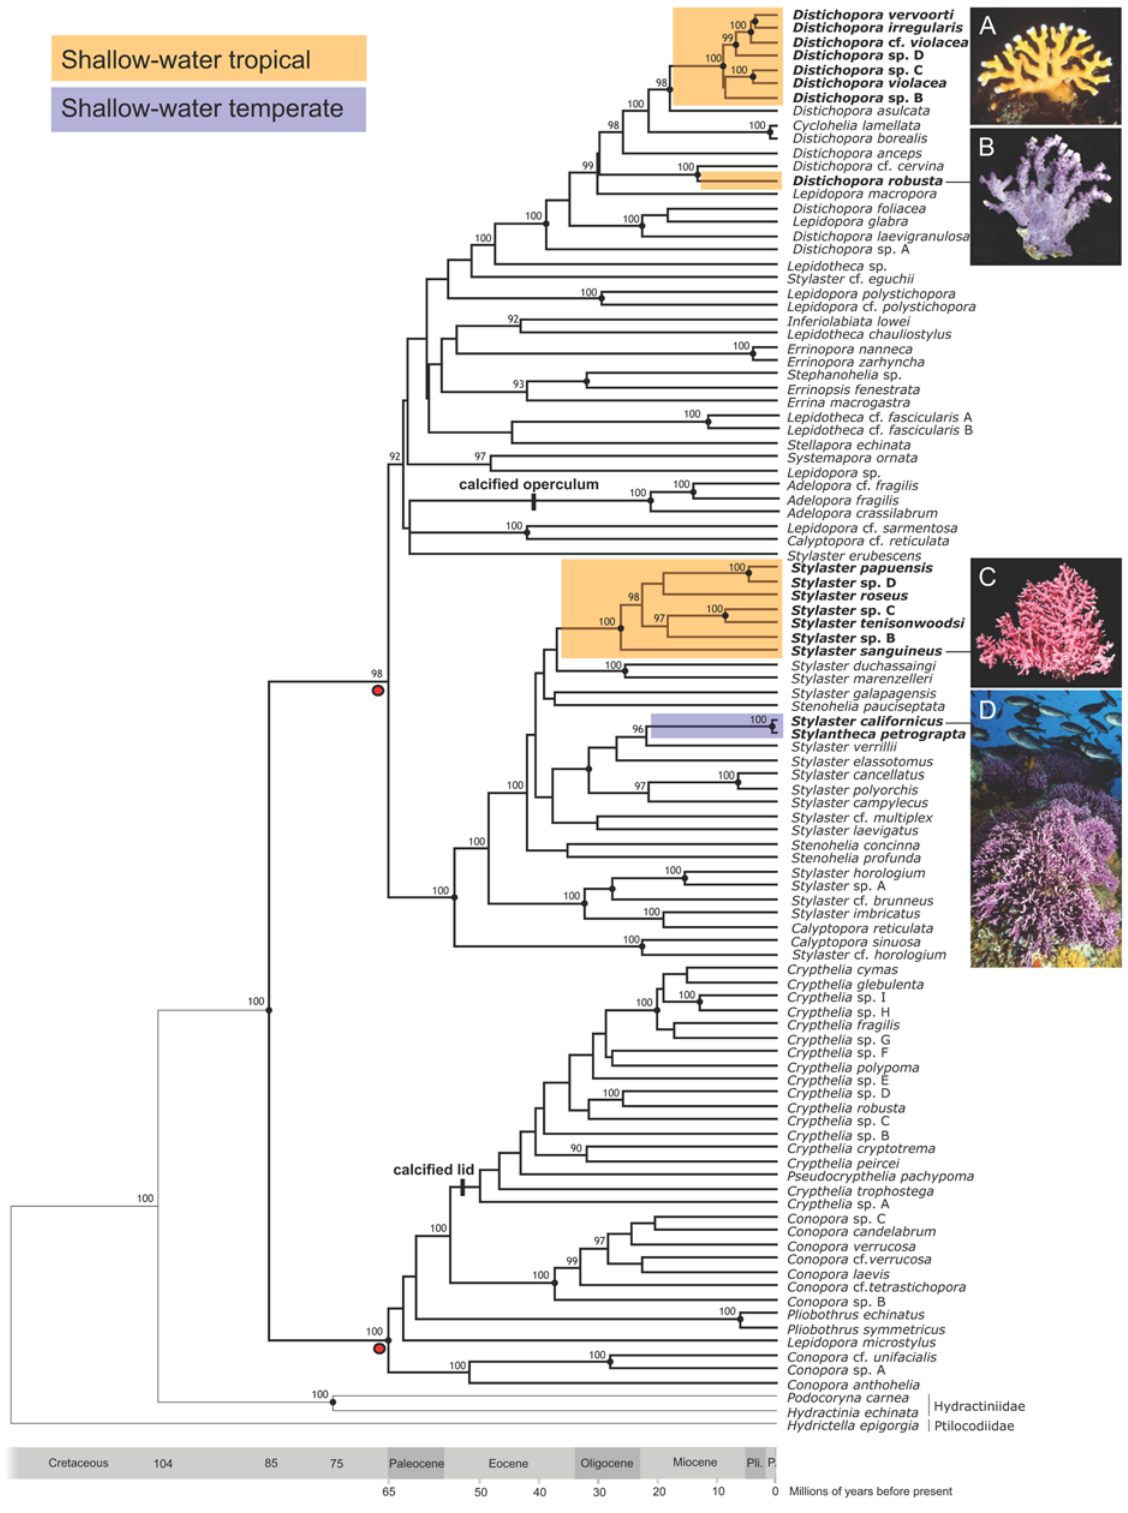
Figure 2. Phylogenetic relationships of stylasterid corals and multiple invasions of shallow waters. (A) Tropical Indo-West Pacific species of Distichopora . (B) Tropical Eastern Pacific species Distichopora robusta . (C) Circumtropical species of Stylaster . (D) Temperate North Pacific species Stylantheca petrograpta and Stylaster californicus. Remaining stylasterid species are deep-sea dwellers. The tree was estimated by maximum likelihood (ML) using a 2638 bp DNA dataset ( 2 ln likelihood 25390.87513). Character state reconstructions estimate the ancestral environment of stylasterid corals as deep water (probabilities of 0.98 and 0.97 using Mk1 and AsymmMk models, respectively [43]). The hypothesis of a single invasion of shallow waters is rejected (p , 0.001, Shimodaira-Hasegawa test [46]). Nodes marked with red circles are calibrated using the earliest stylasterid fossils, 65 mya. Numbers are Bayesian posterior probabilities whenever . 90%; dots at nodes indicate bootstrap support values whenever . 70% for both parsimony and maximum likelihood. Images courtesy of B Hoeksema (A), SD Cairns (B), PMS Peres (C), R Morse (D).